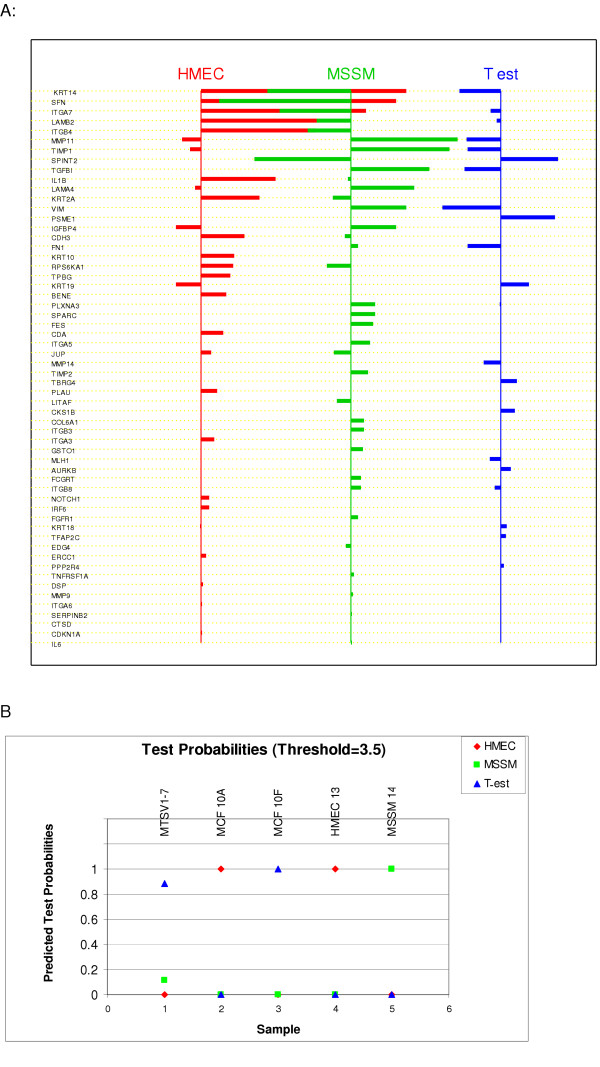
PAM (Prediction Analysis of Microarrays). This is a statistical technique for class prediction from gene expression data using nearest shrunken centroids. This method identifies the subsets of genes that best characterize each class. a) Plot of the shrunkencentroids for the specified threshold with the ranked list of significant genes that are used for the predictions. b) Prediction and probabilities of the test cell lines (MTSV1-7, MCF10A, MCF10F, HMEC 13 and MSSM 14).